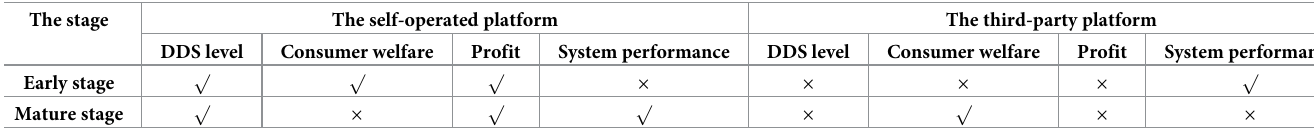
Table 4. The dominance of platforms’ various indicators in the early and mature stages. The stage The self-operated platform The third-party platform DDS